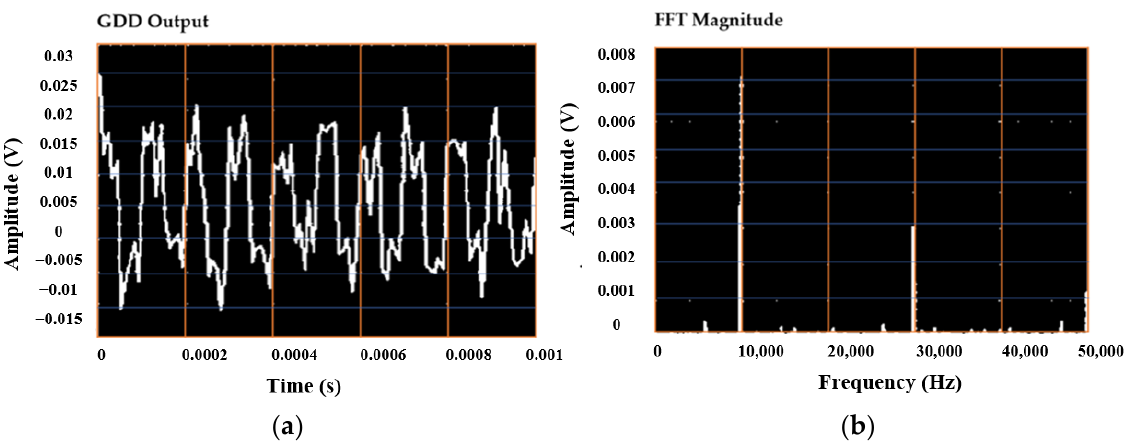
Figure 6. ( a ) Output waveform from an individual GDD in the row detector and ( b ) magnitude of the FFT of that GDD output signal.